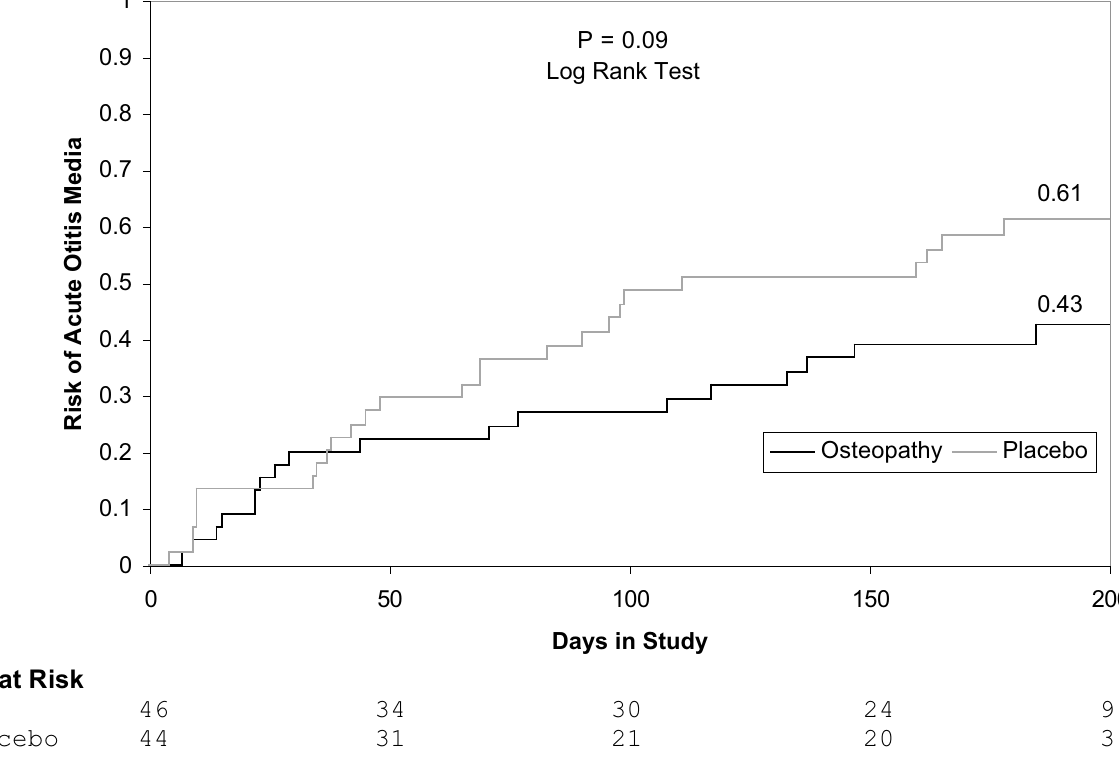
Table 2: Cox regression estimates of the effect of echinacea and osteopathic manipulative treatment on the risk of AOM after adjustment for other factors